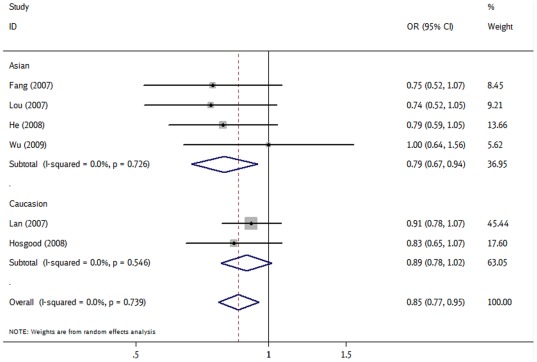
Forest plot of cancer risk associated with rs1052576 under allele contrast (A vs G) in different ethnicity.The squares and horizontal lines correspond to the study-specific OR and 95% CI. The area of the squares reflects the study specific weight (inverse of the variance). The diamond represents the pooled OR and 95% CI.